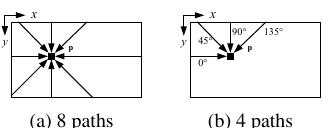
Figure 1: Investigated path orientations for eight and four paths. where p = [ p x , p y ] T is the pixel location in the left image and